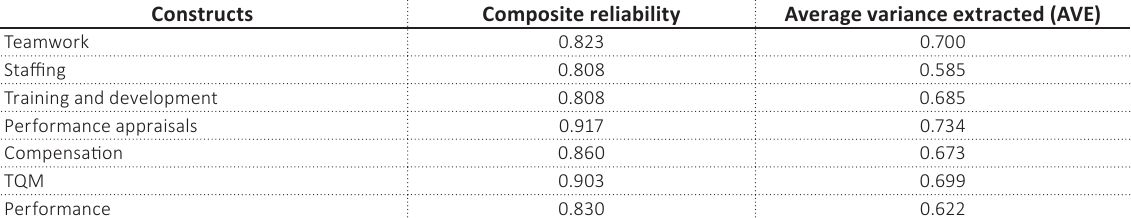
Table 3. Convergent validity